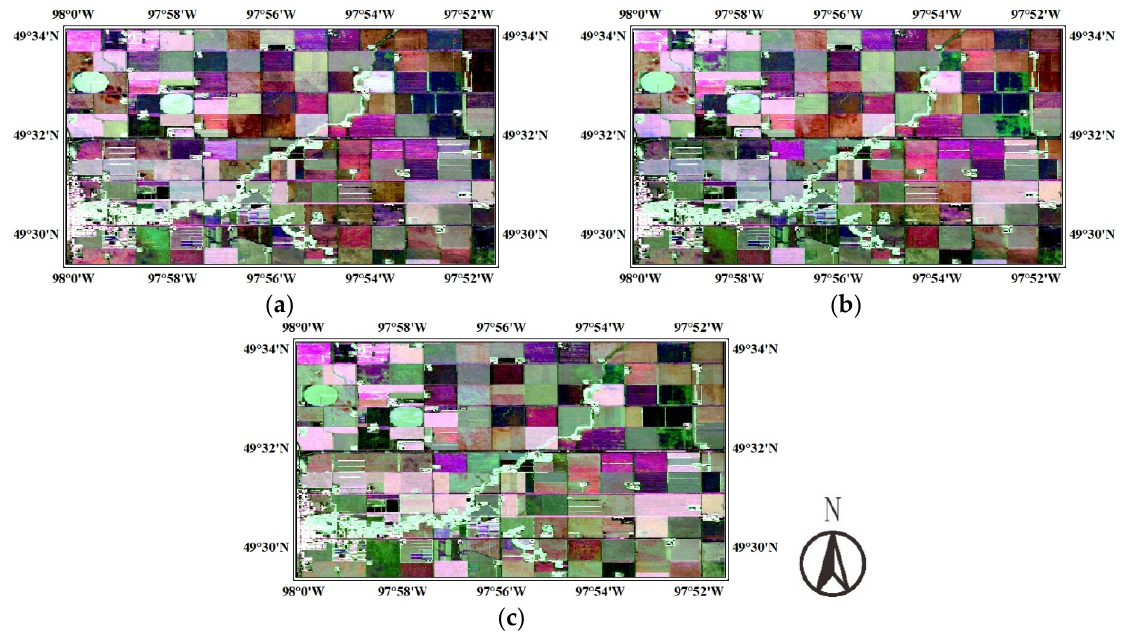
Figure 1. PauliRGB images of multi-temporal UAVSAR dataset. ( a ) Domain A (2012-07-05); ( b ) Domain B (2012-07-08); ( c ) Domain C (2012-07-17).